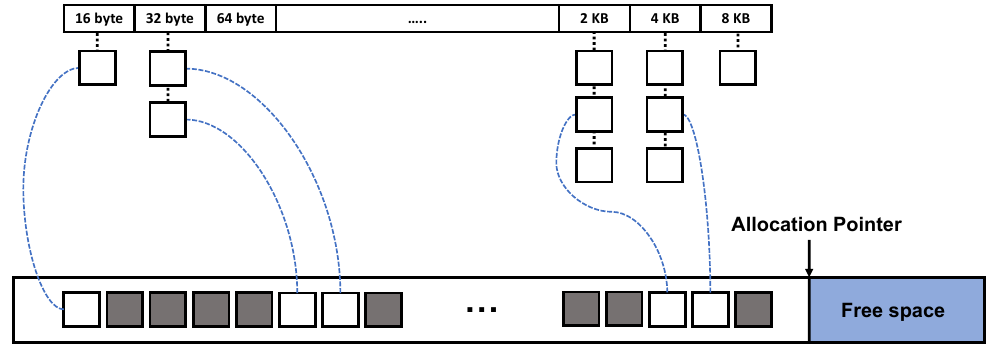
Figure 5. Managing address space in the data